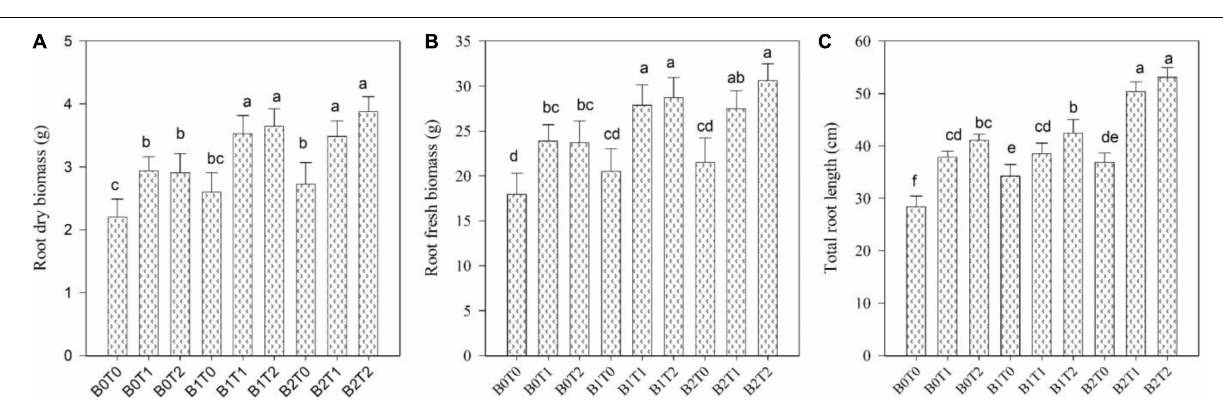
Figure 2 | Effect of combined application of TU and BC on (A) root dry biomass, (B) root fresh biomass, and (C) total root length grown under Cd contamination. Values are averages ± SD ( n = 3). Different statistical letters represent significant differences in values between treatments ( p < 0.05). TU, thiourea; BC,